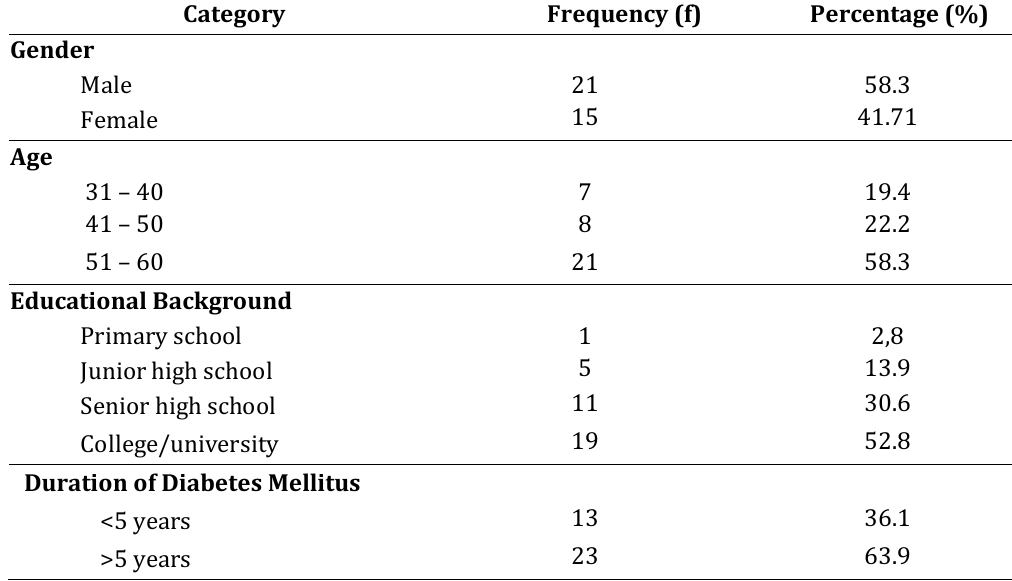
Participant’s Characteristics